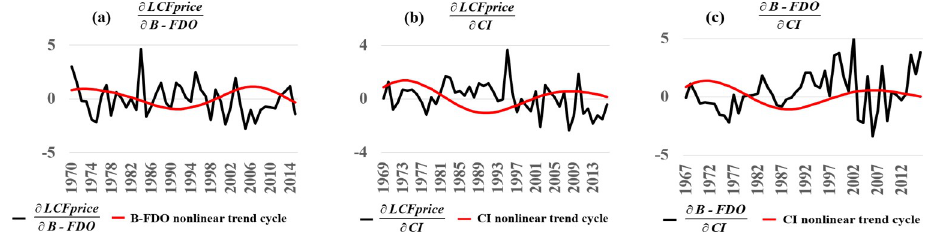
Fig 5. Causality quantification. The S-Mapping method of Deyle et al. (2018) was used to compute partial derivatives measuring the marginal change in a response variable X to an incremental change in a driving variable Y ( @ X / @ Y ) in each year for each interaction in the causal network diagram (Fig 4). Each computed marginal response (black curves) exhibited some regularity depending on the phase of multi-decadal nonlinear trend cycles isolated with SSA (red curves). (a) The @ LCFprice/ @ B-FDO response follows a 4-year cycle whose values are mostly positive when standardized B-FDO is below average along the B-FDO multi-decadal cycle (1980–1997), and is erratic when B-FDO is above average along the multi-decadal cycle. (b) The @ LCFprice/ @ CI response is predominantly positive (72% of years) when standardized CI is below average along the CI mult-idecadal cycle (1981–1998), and otherwise more erratic. (c) The @ B-FDO/ @ CI response is predominantly positive (78% of years) when CI is below average along the multi-decadal CI cycle (1981–1998), and otherwise more erratic.